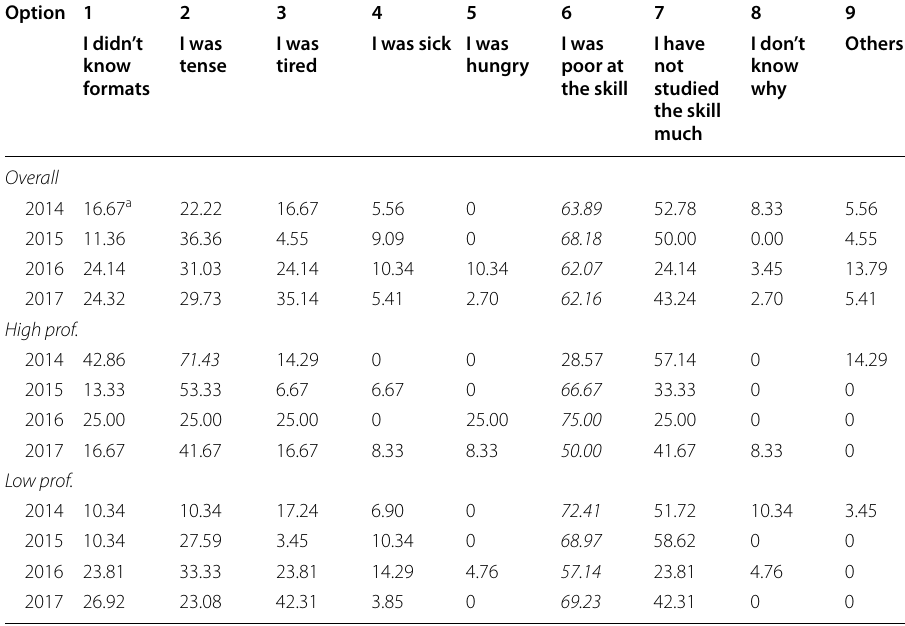
Table 10 Test-takers’ views toward reasons of having uneven profiles in Study